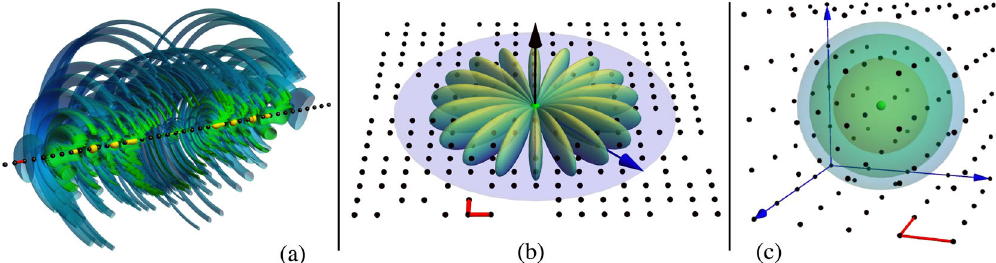
FIG. 1. Schematics of the three scenarios we consider: (a) a linear lattice (1D), (b) a monolayer (2D), and (c) a cubic lattice (3D) with the Rydberg ion in the center, respectively. In each panel the black spheres represent scatterers sitting on lattice sites and the red lines give the lattice spacing d . The missing scatterers in (b) represent a situation with incomplete filling. The volume of scatterers situated within the Rydberg wave function is represented by the blue circle in (b) and by the sphere in (c). The exemplary densities shown give different representations of the composite ’ s electronic wave function in these three scenarios. In (a) the strongly perturbed wave function is shown with three surfaces of constant density, revealing the exotic nature of these wave functions. The full 3D contour is cut away in front to reveal the interior structure. Figure 3 provides details of the plot parameters. Panel (b) shows a contour of the angular dependence of a typical circular state, which plays a crucial role in the 2D composite ’ s properties (see Sec. IV). Panel (c) shows an illustration of the Rydberg atom, illustrating that the spatially varying probability cloud spans many lattice sites of the 3D